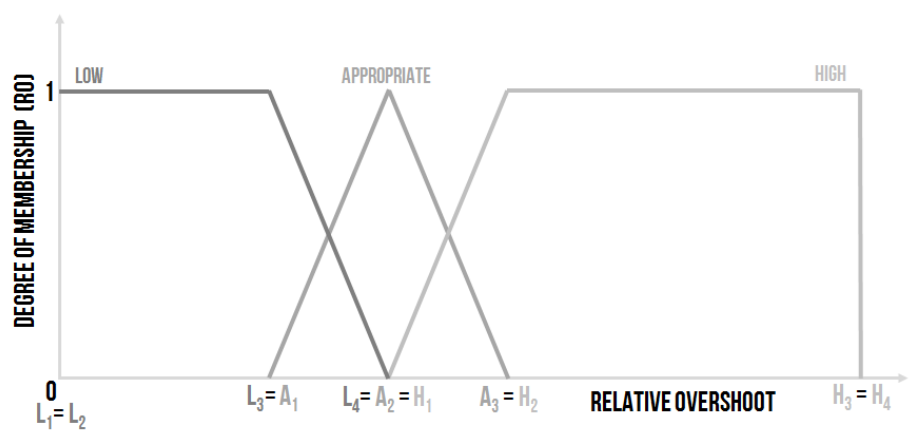
Figure 5. The shape of the membership functions of the linguistic values for the input linguistic variable Relative Overshoot (RO)–design no. 1 [30].